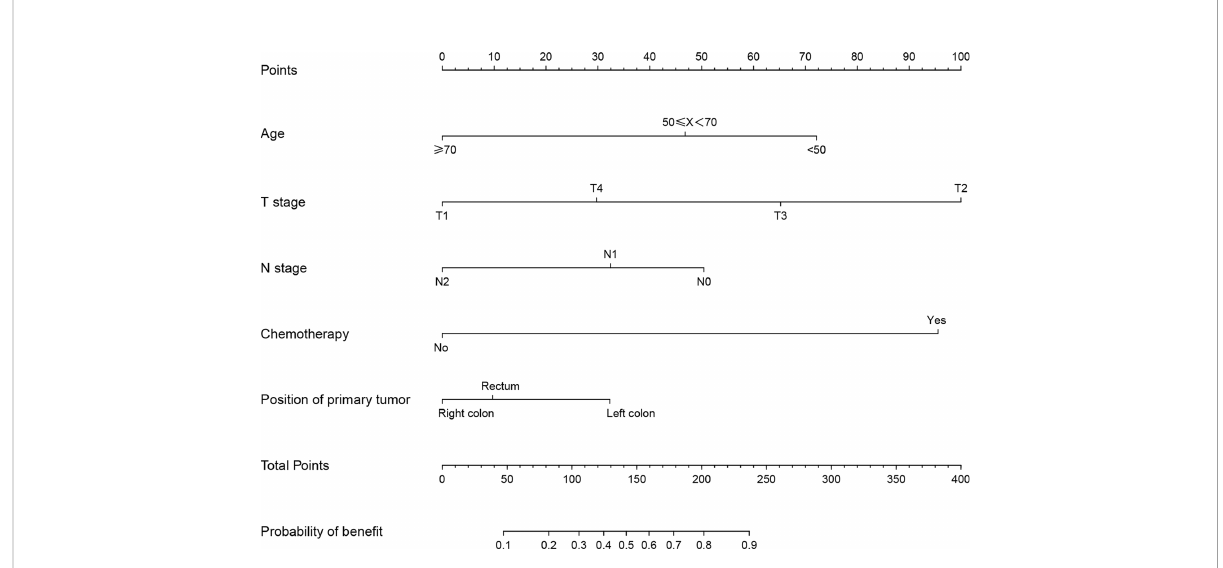
FIGURE 3 Construction of the CRLM nomogram. CRLM, colorectal cancer with liver